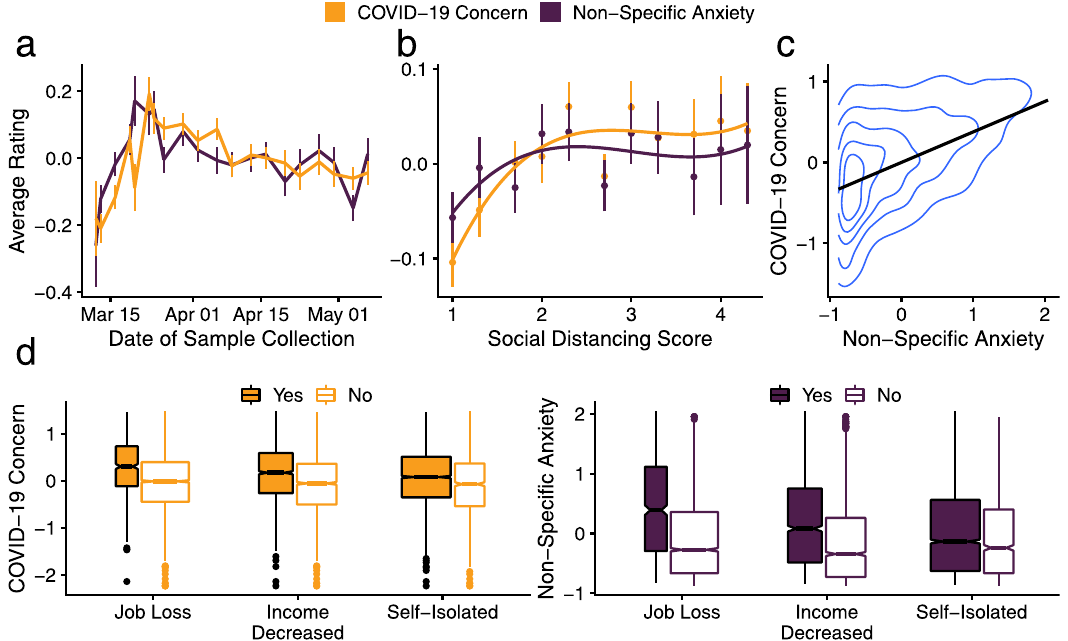
Fig. 5 Motivational state metrics track real-world circumstances. a Standardized rating of COVID-19 concern increased sharply mid-March 2020, a similar pattern is observed for non-speci fi c anxiety. Data presented as mean values ±1 SEM; n = 5375 participants. b COVID-19 concern is higher for people in states where social distancing is practiced, as measured by Unacast via smartphone location data 75 . Data presented as mean values ±1 SEM, lines are predictions from a general additive model; n = 5302 participants. c Non-speci fi c anxiety and COVID-19 concern are moderately correlated r = 0.44, n = 5376, two-sided p = 2.16 × 10 − 248 ; black line derived from linear regression. d COVID-19 concern levels (plotted on the left) are higher among participants who had lost their jobs, had seen their income decrease, or went into self-isolation. The same was true for speci fi c anxiety, plotted on the right. Boxplots: central lines denote median, hinges mark the interquartile range (IQR), whiskers 1.5 times the IQR, width of box proportional to the square root of the number of participants; overall n = 5375 participants. Source data are provided as Source Data fi